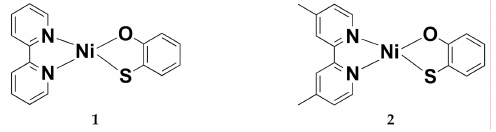
Figure 1. Structures of the complexes 1 and 2